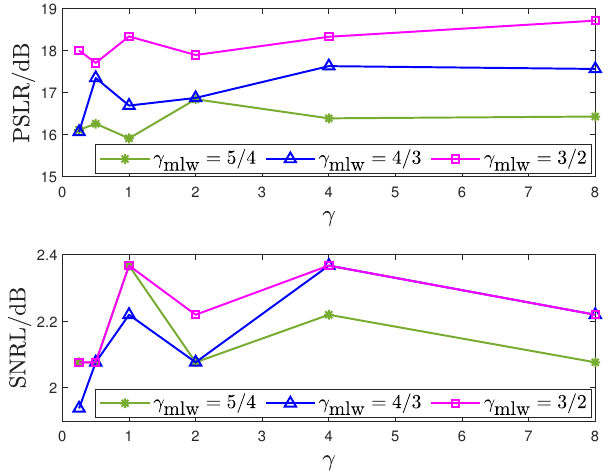
Figure 8. SNRL, PSLR versus different γ